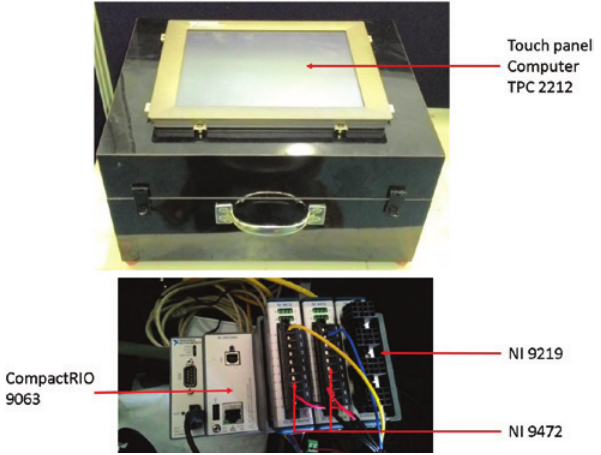
Figure 4: Portable unit of the pressure test rig – Pressure control system (TPC 2212 with CompactRIO 9063, NI modules 9219 and 9472).